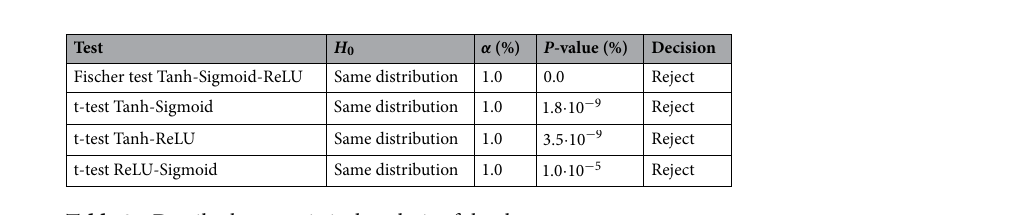
Table 3. Details about statistical analysis of the three